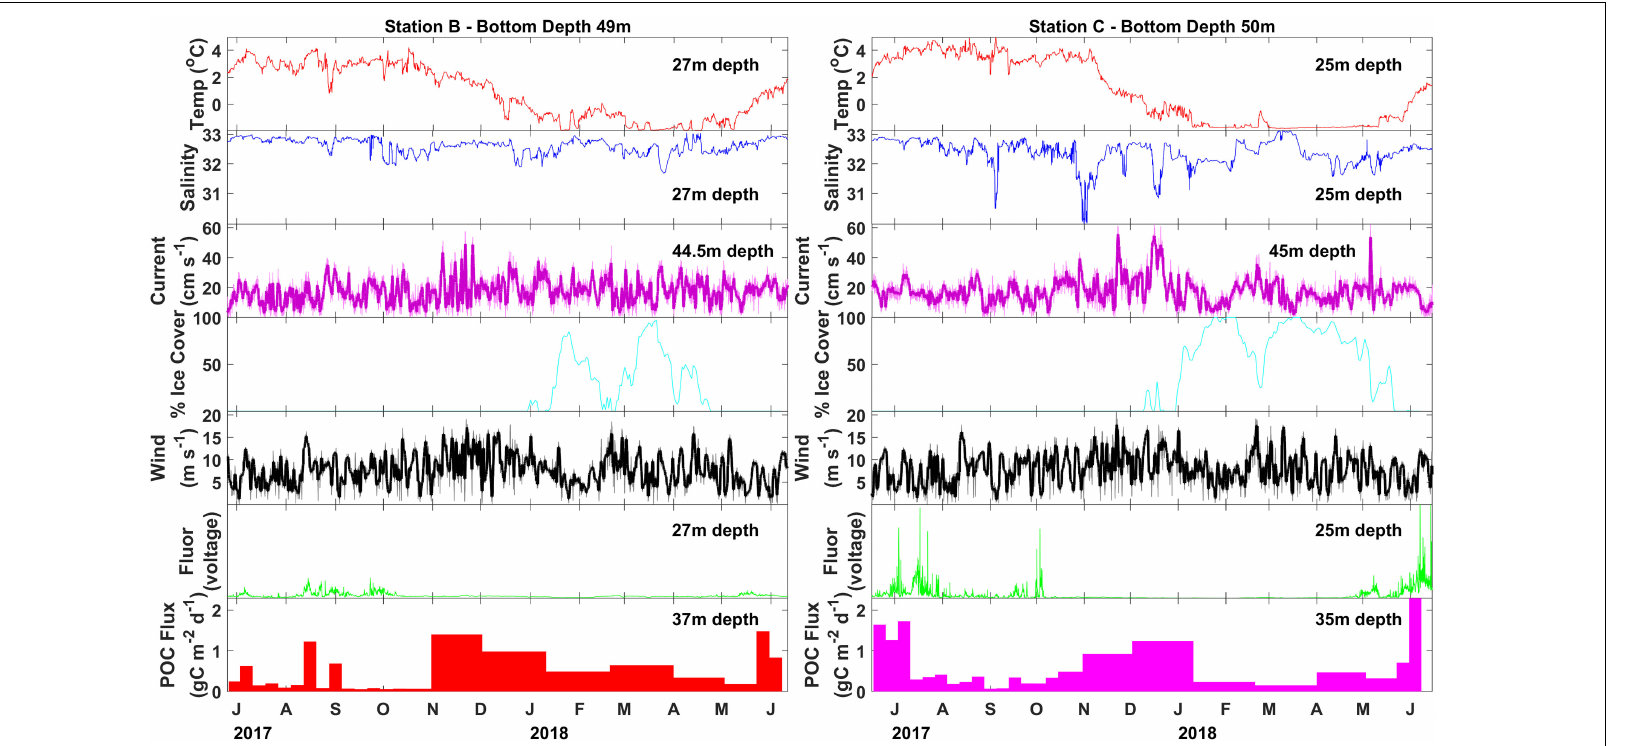
FIGURE 5 | Particulate organic carbon flux (colored bars) measured with moored sediment traps at stations N4 and N6 between June 2017 and June 2018. Sea ice percent cover (cyan line) taken from NSIDC satellite records (Fetterer et al., 2017). Wind velocity (black line) taken from modeled wind reanalysis (European Centre for Medium-Range Weather Forecasts, 2019). Twenty-four hour smoothing is shown with the thick black line. Lowpass-filtered current velocity (magenta line) taken from AD, with 12 h smoothing shown with the thick magenta line, temperature (red line), salinity (blue line), fluorescence (green line) taken from seabird SBE16plus unit coupled with a WetLabs fluorometer on each of the